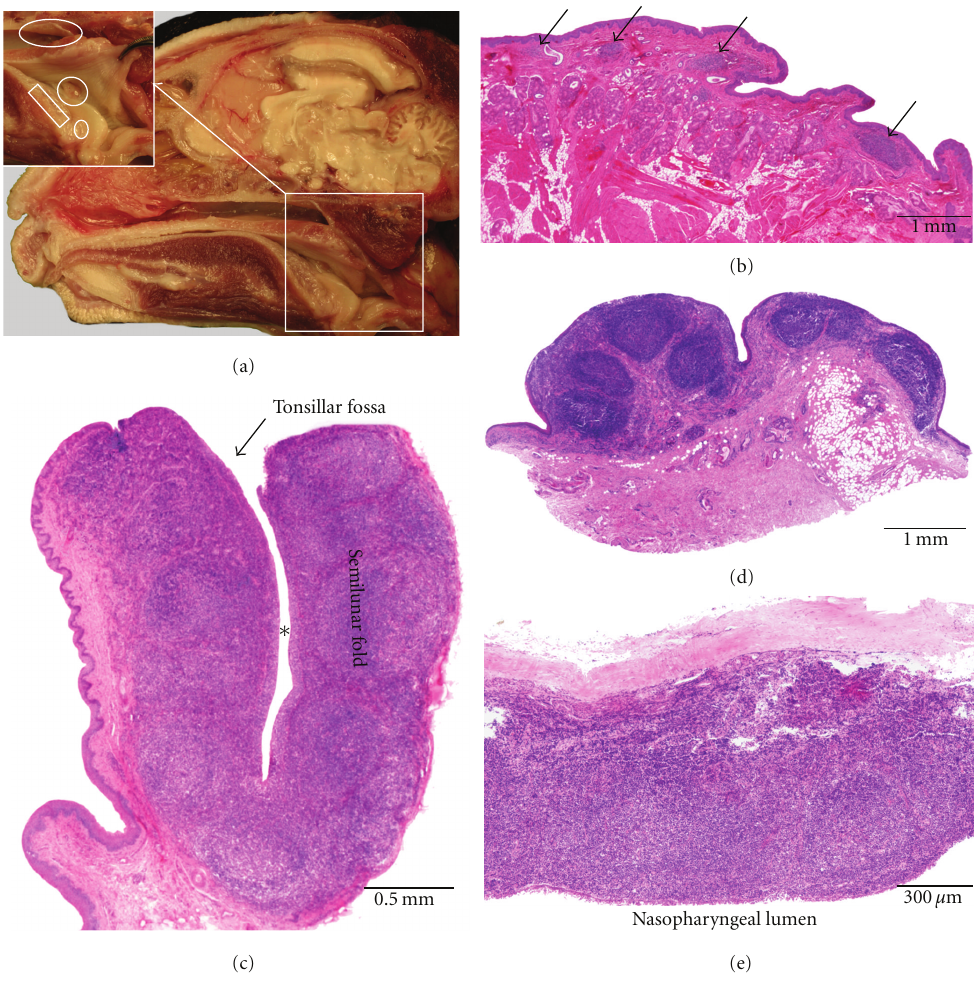
Figure 7: Anatomical localization and histological characteristics of the feline tonsils. (a) Median section through a feline head. The insert shows a larger magnification of the region in which the tonsils are located. The lingual (rectangular box), palatine (larger circle), paraepiglottic (smaller circle), and pharyngeal tonsils (oval) are indicated. (b) Histological section through a part of the lingual tonsil that is composed of scattered aggregations of lymphoid cells (arrows). (c) Histological section through the palatine tonsil which contains a central tonsillar fossa (asterisk). (d) and (e) Histological sections through the paraepiglottic tonsil (d) and a part of the pharyngeal tonsil (e),